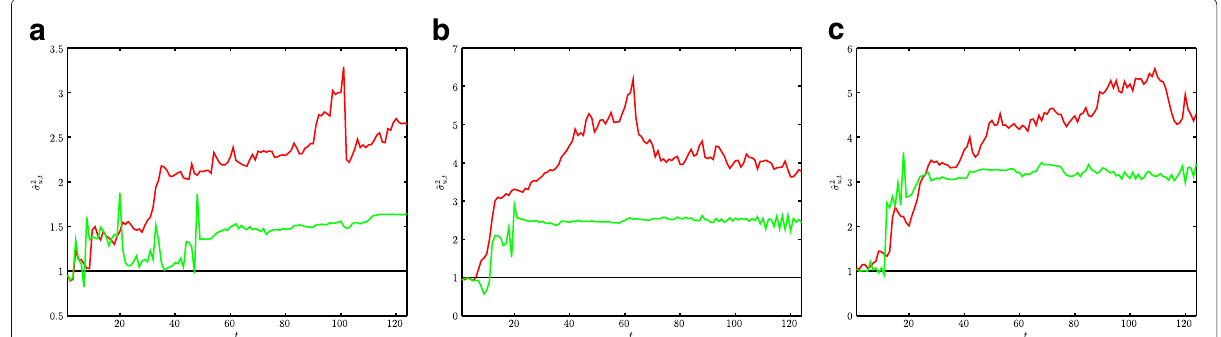
Fig. 5 True (black) and estimated (DA PF in red, IS PF in green) scale factor for the proposed SMC methods with unknown ARMA(1,1) parameters. a ARMA(1,1), H = 0.5. b ARMA(1,1), H = 0.7. c ARMA(1,1), H = 0 : 9